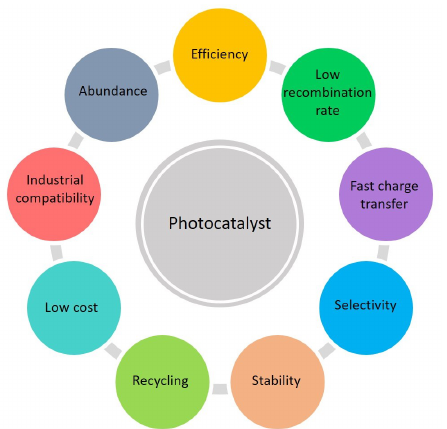
Figure 3. General requirements for designing high-efficiency